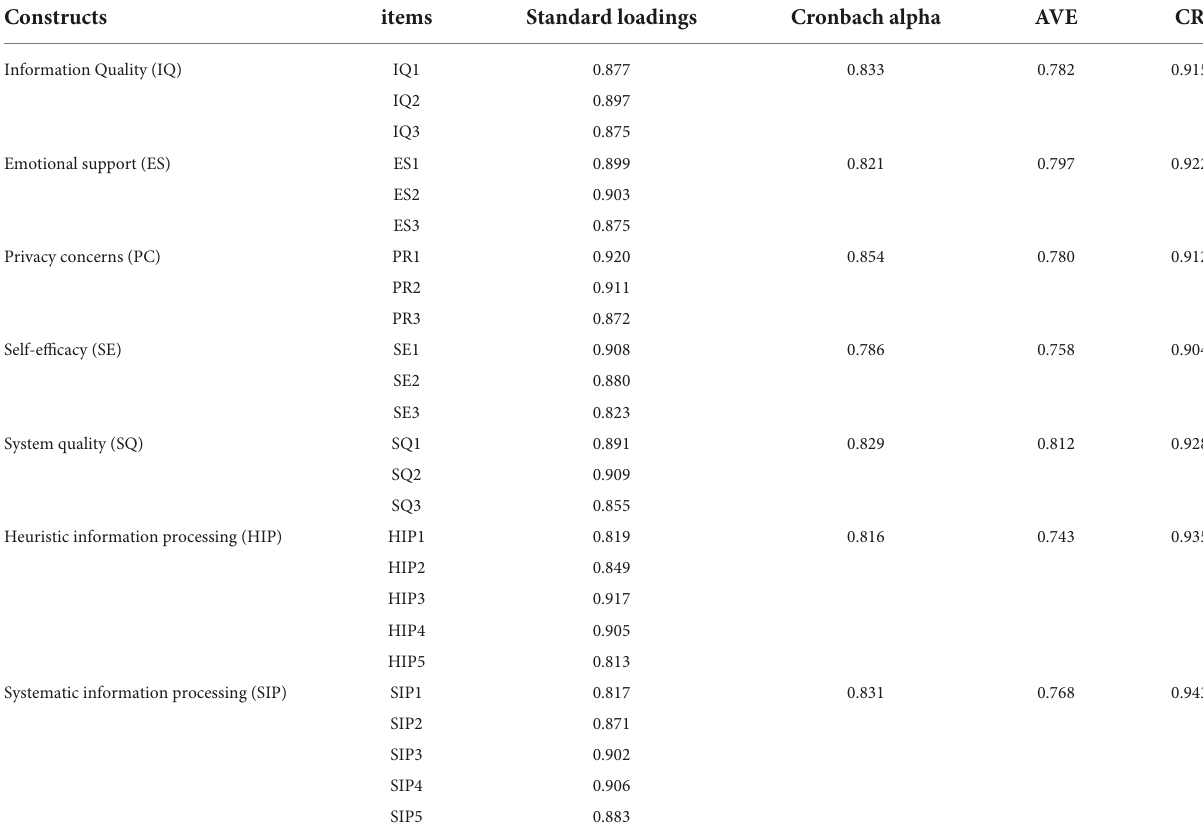
TABLE 3 Statistical results of the research model.